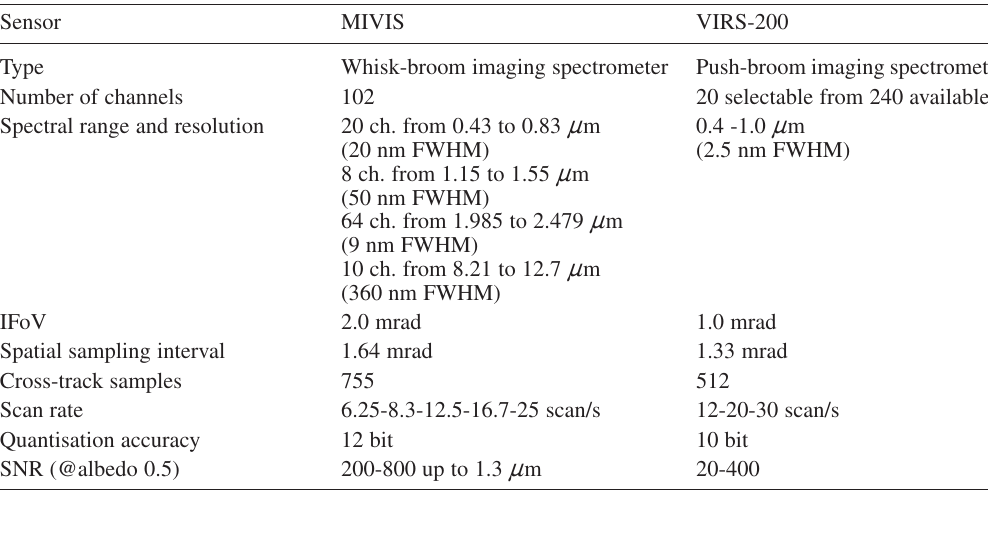
Table II. Spectral and radiometric characteristics of the MIVIS and VIRS-200